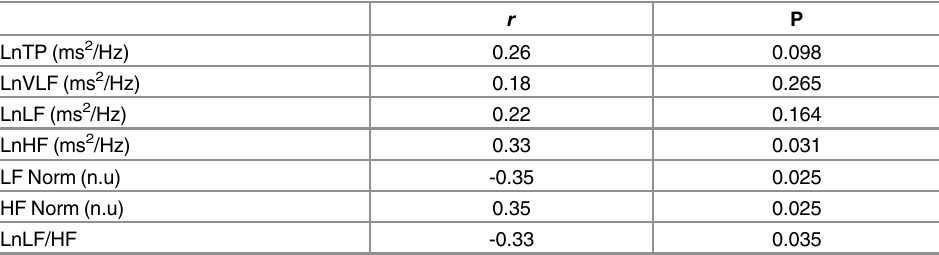
Table 2. Correlations between FBG levels and frequency domain HRV indices.